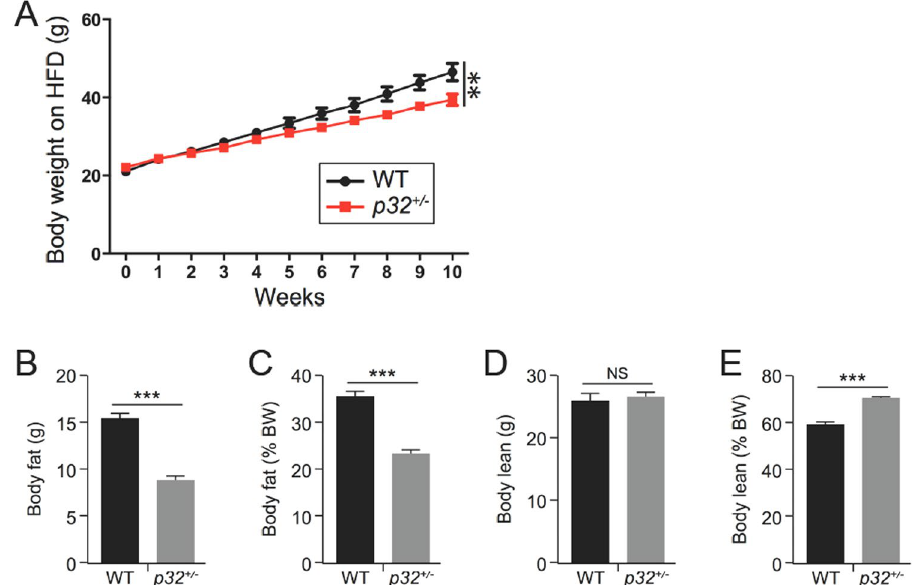
Figure 2. p32 heterozygous mice are resistant to HFD-induced obesity. ( A ) Body weight of 8-week-old WT and p32 + / − male mice fed a high-fat diet (HFD) for the indicated amount of time (WT n = 7; p32 + / − n = 5). ( B – E ) Average total fat ( B ) and lean ( D ) masses and relative fat ( C ) and lean ( E ) masses of WT and p32 + / − mice fed an HFD for 10 weeks (WT, n = 7; p32 + / − , n =